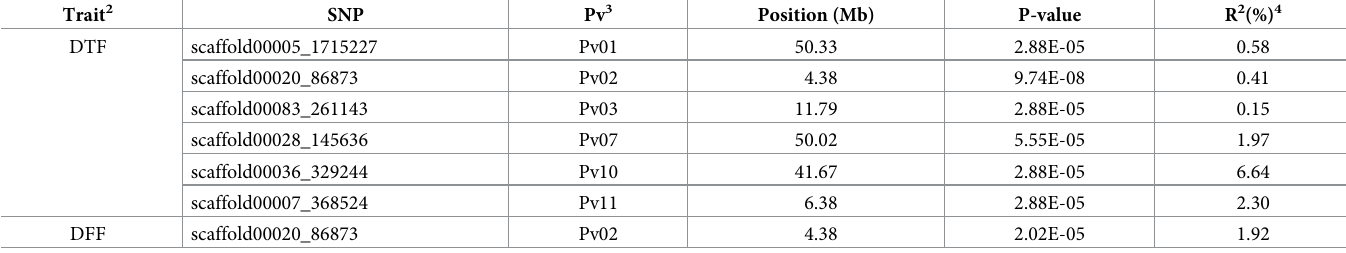
Table 4. Single nucleotide polymorphisms (SNPs) associated with phenological traits in the common bean using quantile regression 1 , chromosome (Pv), position, P -values and proportion of phenotypic variation explained (R 2 ) of most significant, using QR ( τ = 0.1) model. Trait